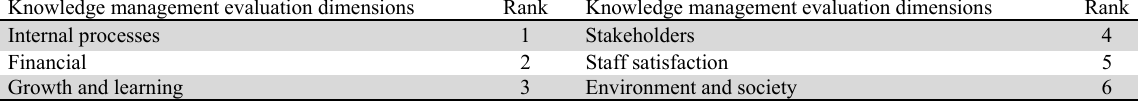
Results of prioritization of knowledge management evaluation dimensions with ORESTE Knowledge management evaluation dimensions